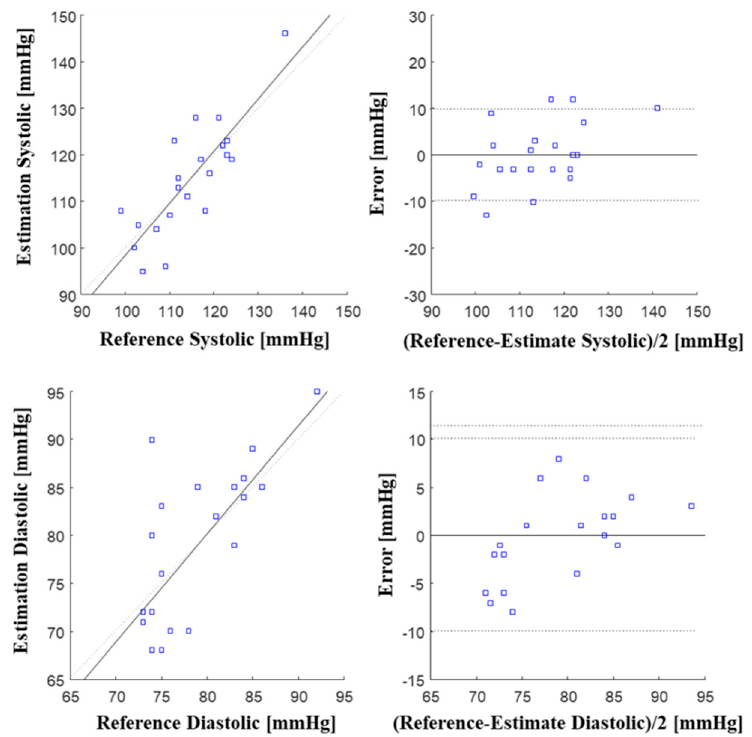
Figure 6. Bland–Altman plot and regression plot in systolic and diastolic periods.